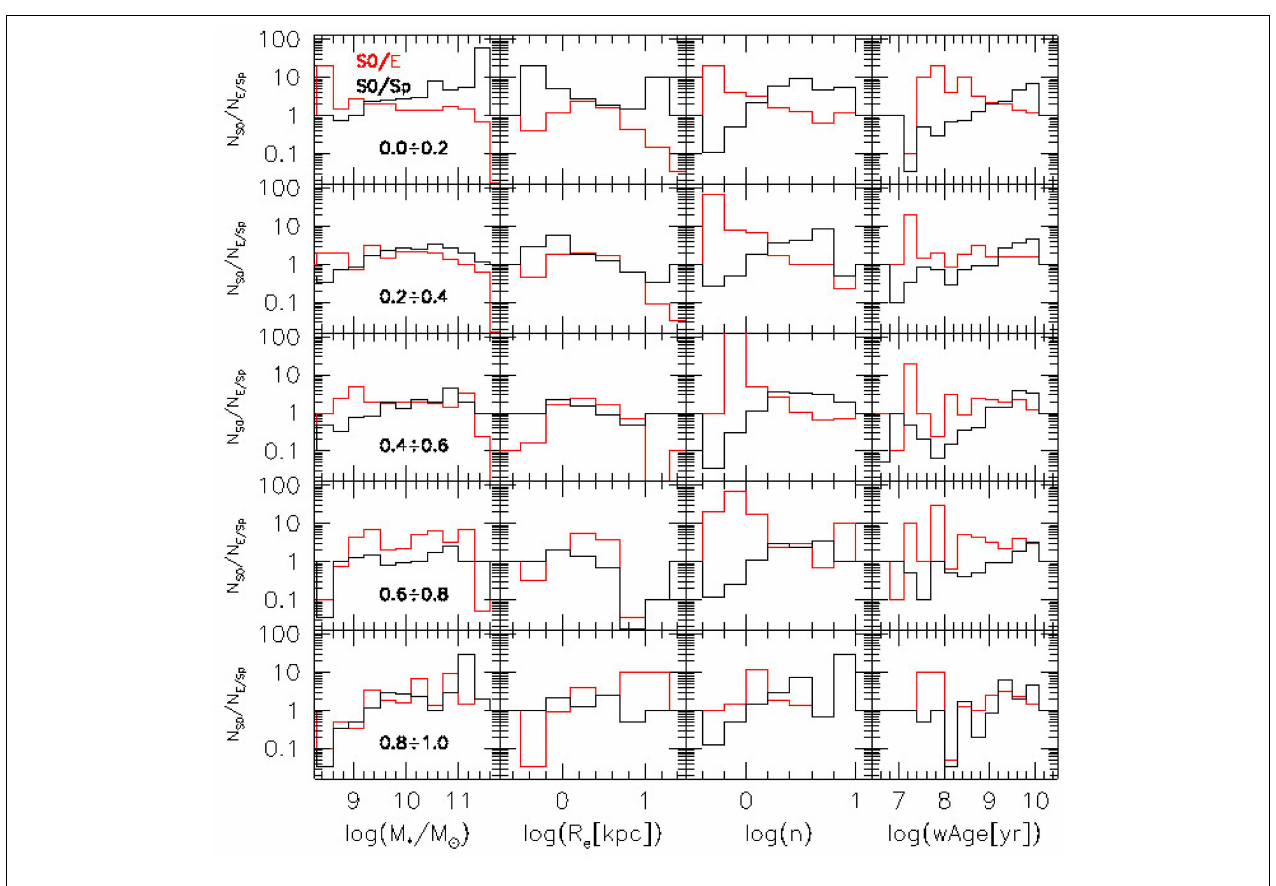
FIGURE 8 | From left to right: the log of the total galaxy mass (log ( M ⊙ ) , the circularized effective radius (log( R c e [ kpc ]), the log Sersic index (log ( n ) ), and the log of the luminosity weighted age (log( wAge )).